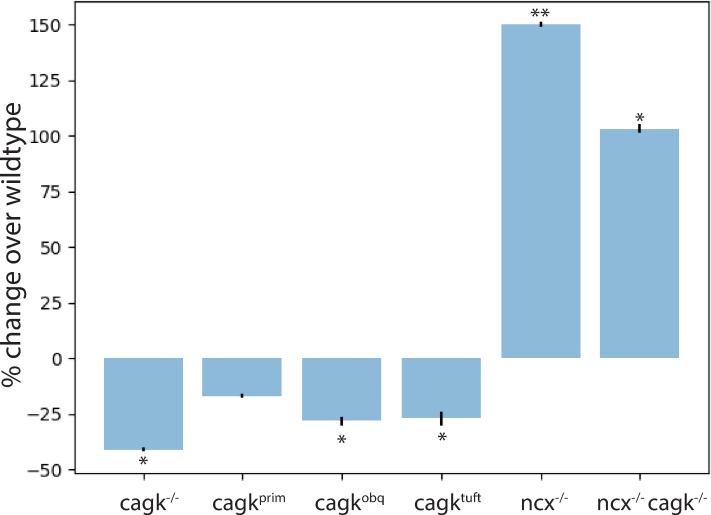
The Ca2+ activated K+ current is required for STDP.Comparison of STDP responses after Ca2+ sensitive K+ current mechanism removal (cagk-/-), insertion of the Ca2+ sensitive K+ current into the primary dendrite region (cagkprim), insertion of the Ca2+ sensitive K+ current into the oblique dendrite region (cagkobq), insertion of the Ca2+ sensitive K+ current into the tuft dendrite region (cagktuft), and removal of both the Na+/Ca2+ exchange current and the Ca2+ sensitive K+ current from the model (cagk-/-; ncx-/-) as well as removal of the Na+/Ca2+ exchange current (ncx-/-) for comparison. ** indicates p < 0.005, * indicates p < 0.05.